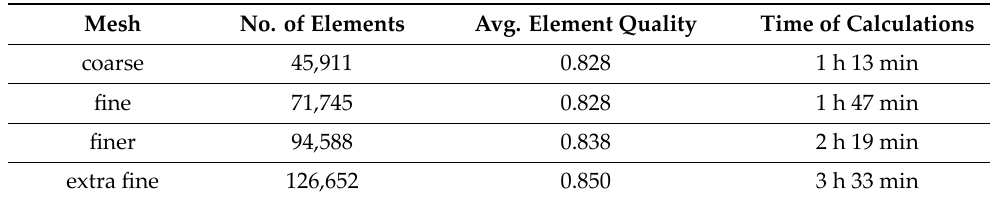
Table 6. Mesh parameters used in calculations of ions concentration and potential distributions in the concrete sample with the corresponding time of calculations. Mesh No. of Elements Avg. Element Quality Time of Calculations coarse 45,911 0.828 1 h 13 min fine 71,745 0.828 1 h 47 min finer 94,588 0.838 2 h 19 min extra fine 126,652 0.850 3 h 33 min